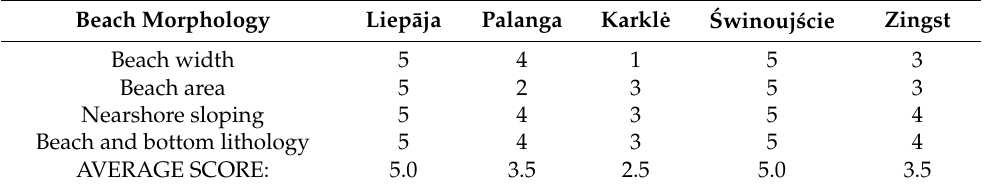
Table 3. Average scores of physical beach quality in the studied South Baltic seaside resorts (scores from 1—poor to